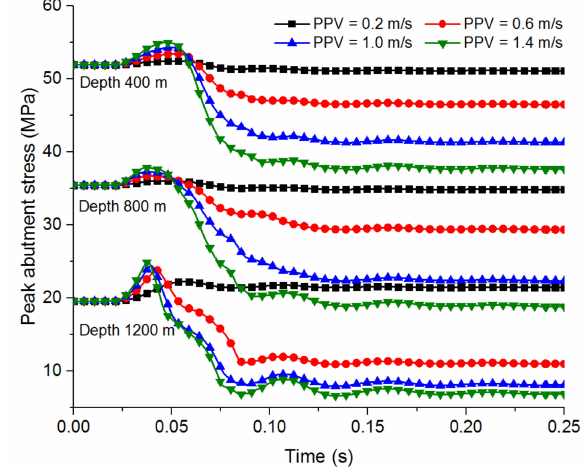
Figure 12. Variations in the peak abutment stress under dynamic